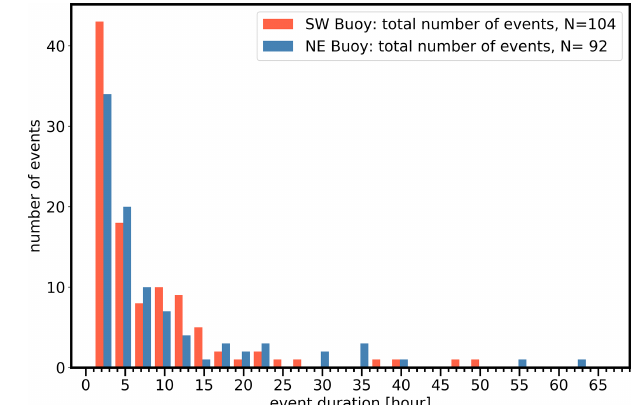
Figure 5. Number of high-shear events for both buoys as a function of event duration. Only events with a minimum duration of 1h are